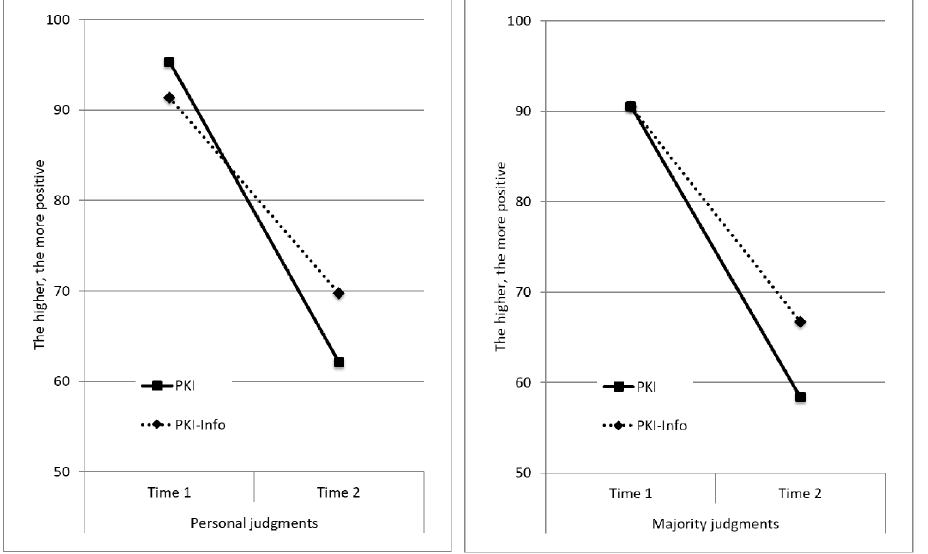
Figure 4. Mean estimates of positive judgments in Study